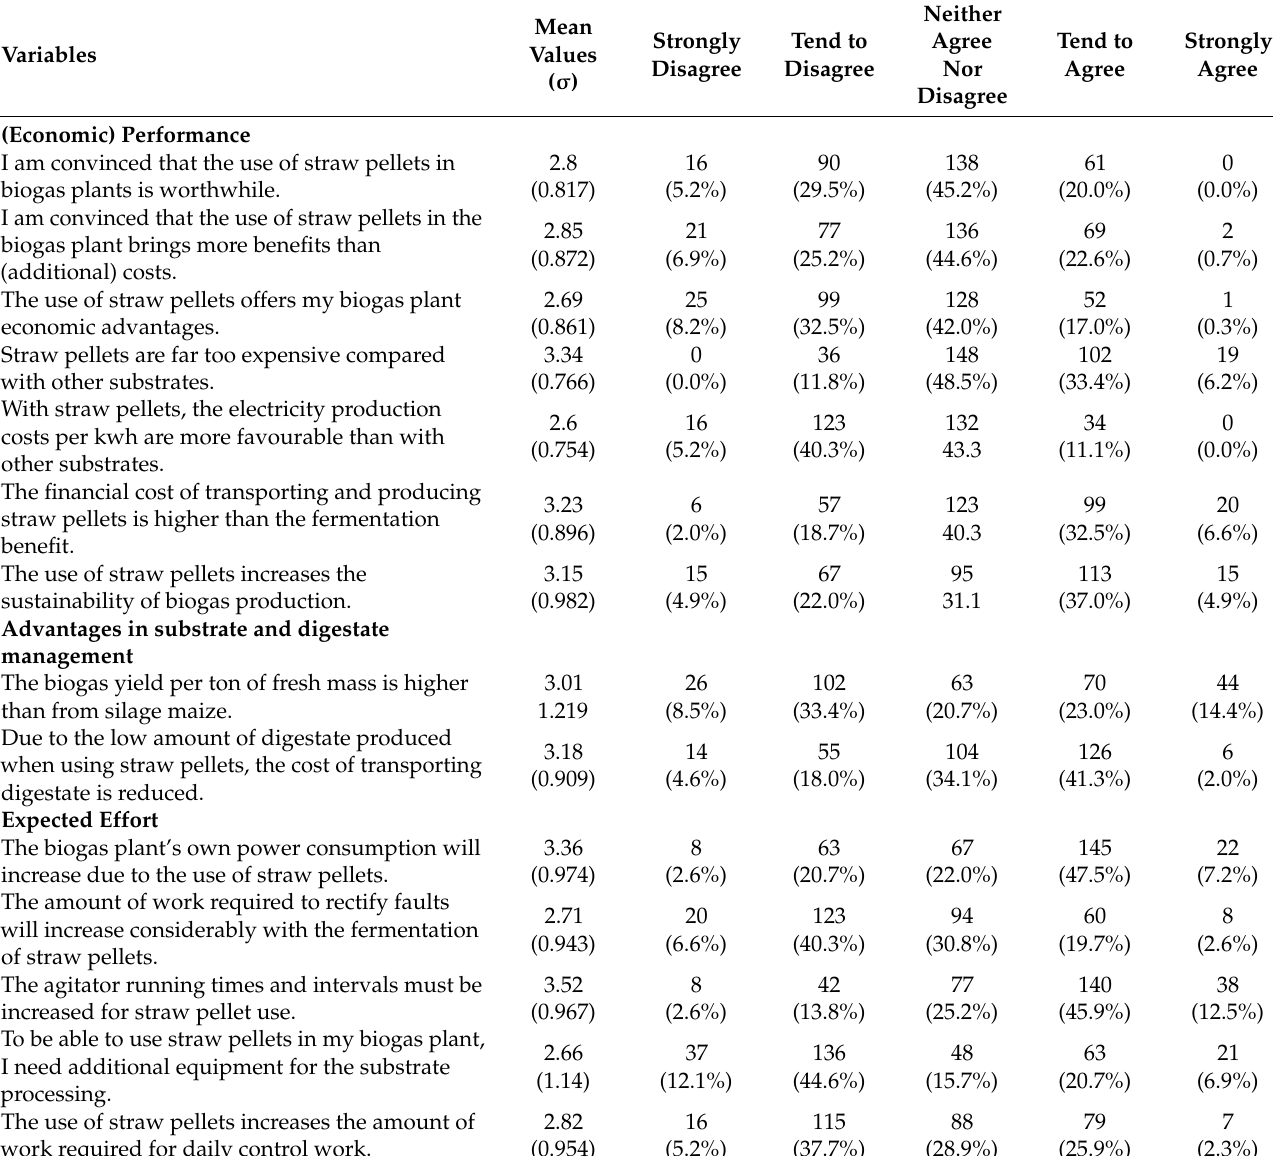
Table A3. Descriptive statistics corresponding to Table